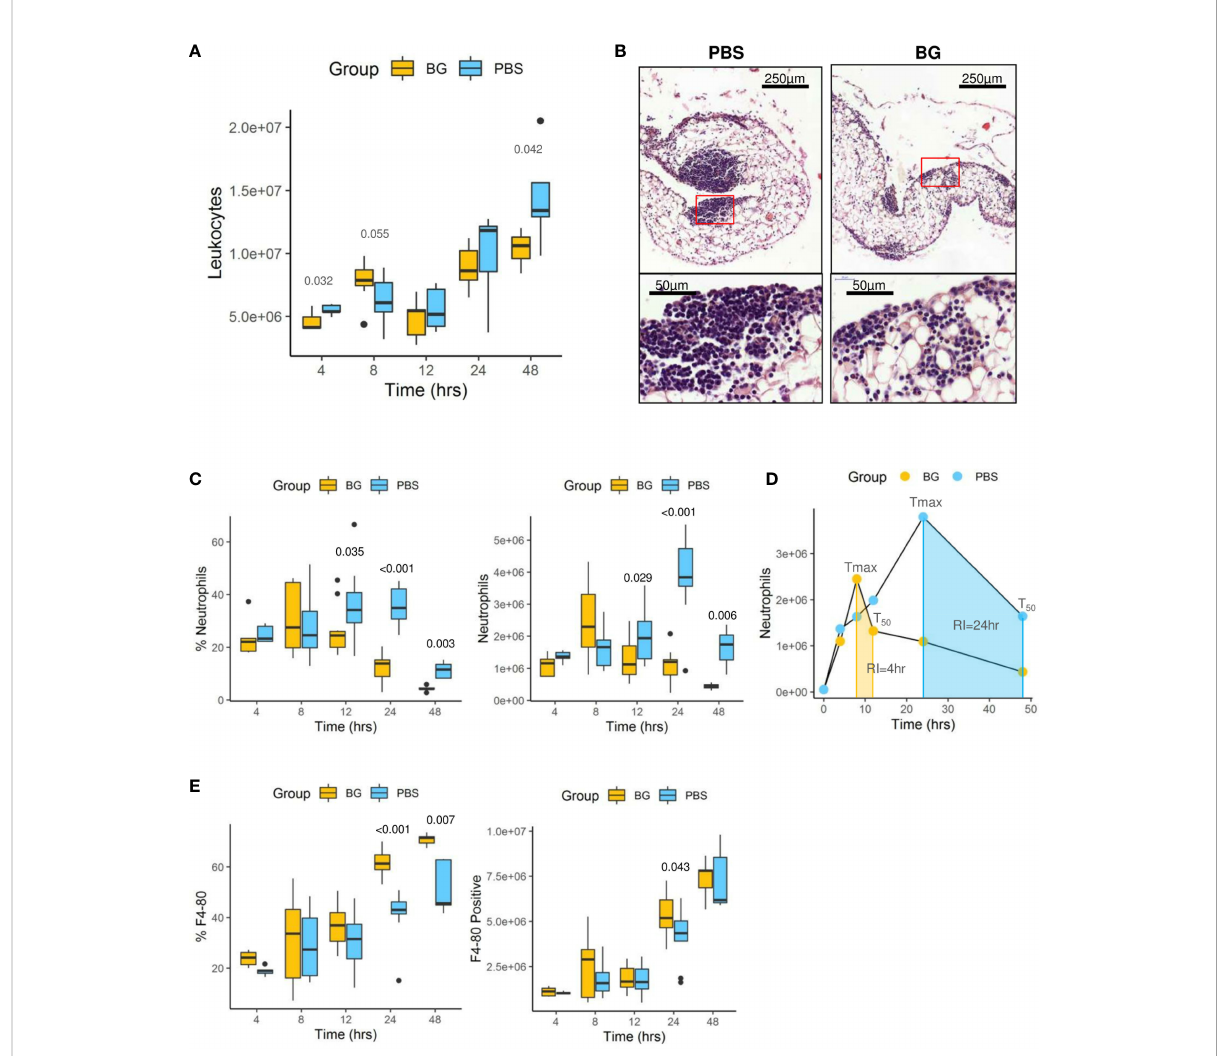
FIGURE 4 Leukocyte in fi ltration in the peritoneal cavity. (A) Flow-cytometry assessment of CD45 + leukocyte numbers. (B) Histological examination of hematoxylin eosin-stained sections of omentum sampled at 24 h p.i. (C) Flow-cytometry assessment of neutrophil (Ly6G pos ) frequency and number in peritoneal exudates. (D) Neutrophil dynamics in each experimental group (T max : time for maximal neutrophil recruitment, T 50 : time for neutrophil numbers to decrease to half T max , RI: resolution interval = T max – T 50 ). (E) Flow-cytometry assessment of F4-80 pos cell frequencies and numbers in peritoneal exudates. Statistical analysis was performed using the Welch t-test and signi fi cant p values are indicated. The number of mice used and experiments are detailed in Supplementary Table